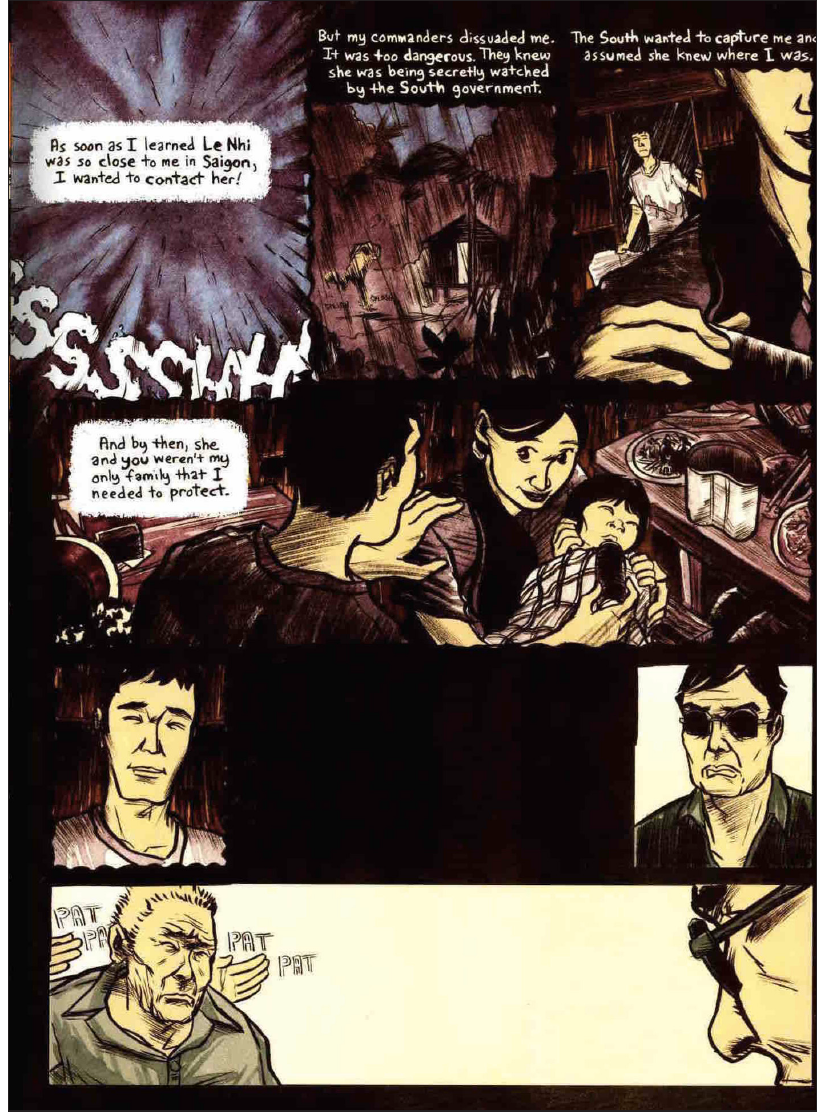
Figure 3: Tran, GB (2010) Vietnamerica (London: Villard, 193)  Gia-Bao